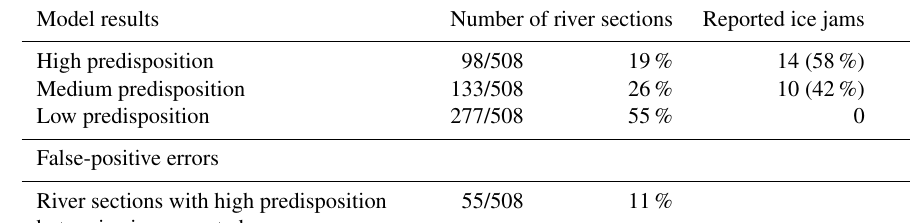
Table 6. Results and accuracy of the IJPI on L’Assomption River.